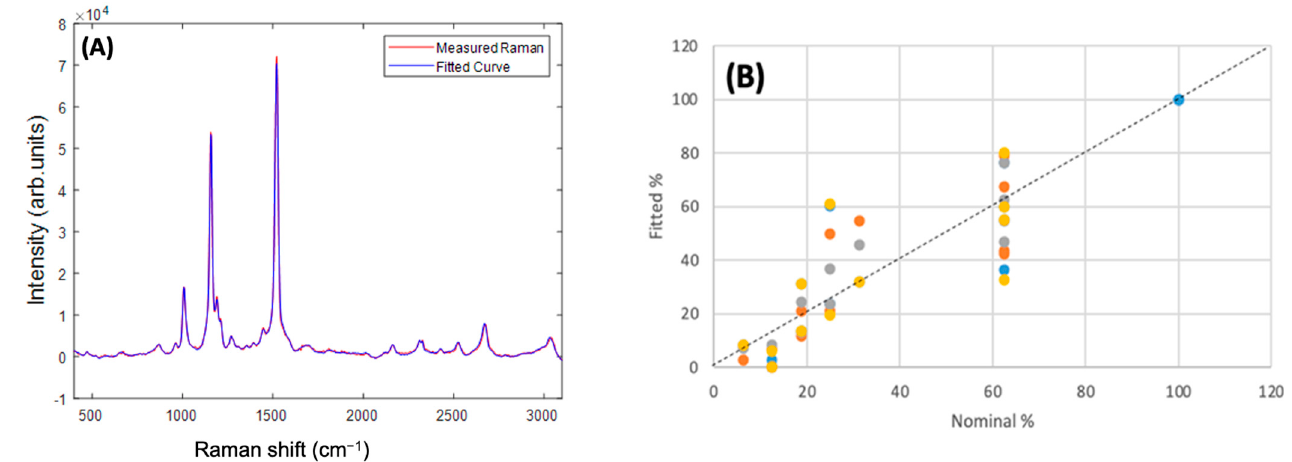
Figure 10. ( A ) Measured and Fitted Raman spectra for the 100:50:10 Beta Carotene:Lutein:Zeaxanthin admixture. ( B ) Fitted% versus Nominal% for each constituent in the range of admixtures. The different colours indicate different replicate measurements.